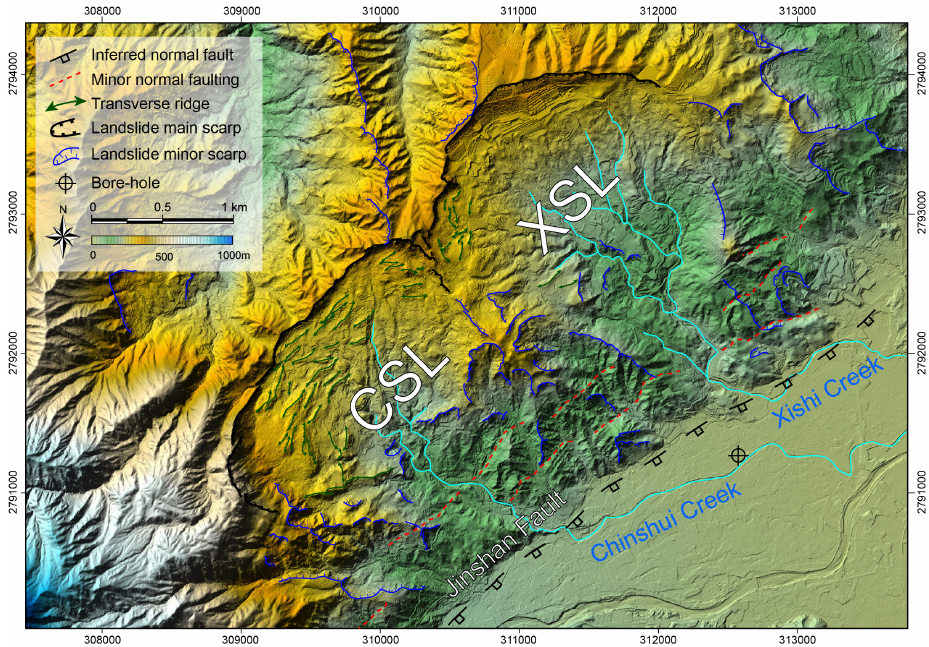
Figure 5. Hillshade map of the study area obtained from the lidar DTM. The morphological features in the depleted zone have been preserved, namely the main scarp, minor scarp, and transverse ridges. Notably, several small landslides are located on the volcano flank within the two main landslides. The region and the location of this figure are indicated in Fig. 4.